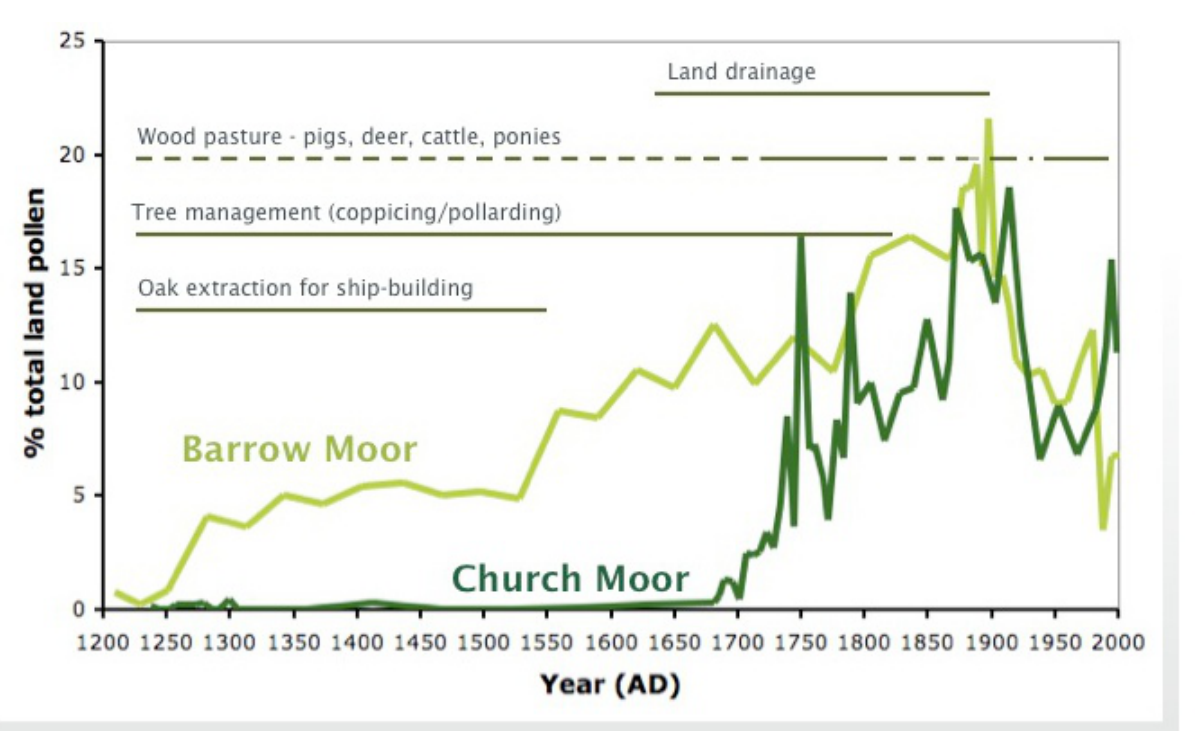
Fig. 4 . Legacies and